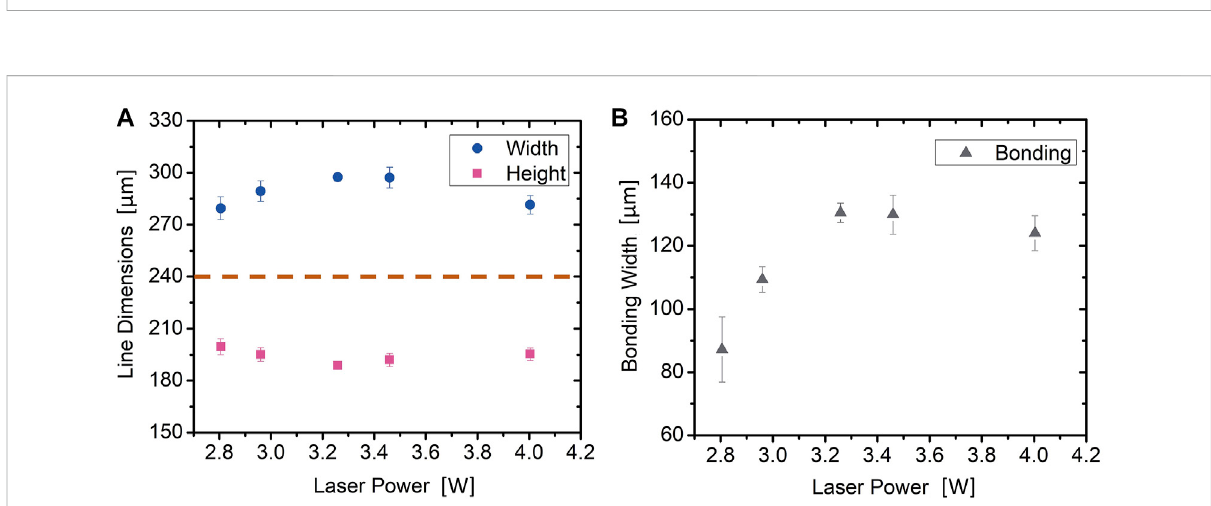
FIGURE 5 The measured line height and width (A) derived from Figure 4, with (B) the corresponding bonding width. The dashed line in (A) indicate height and width (240 µm) for an ideal cylindrical line. Error bars are standard deviation ( n =